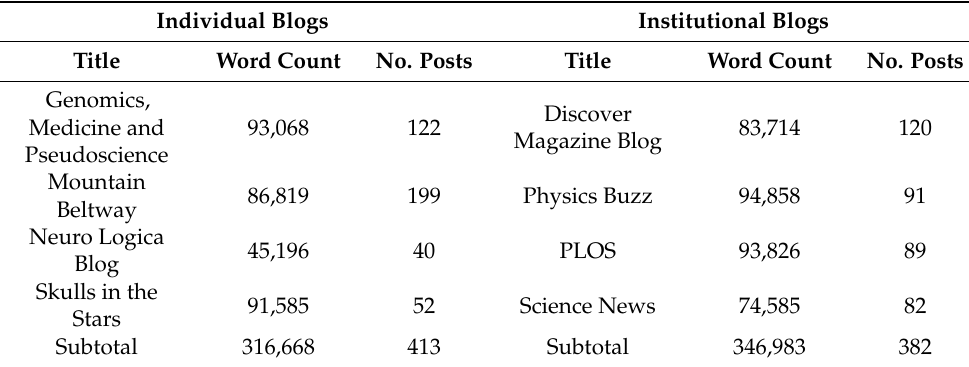
Table 1. Composition of the blog post